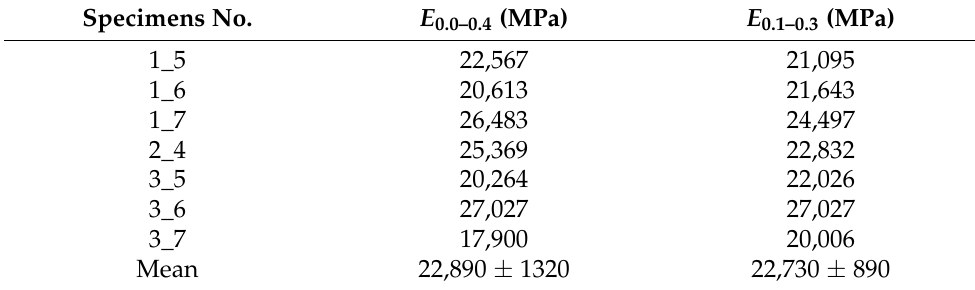
Table 4. Modulus of elasticity.